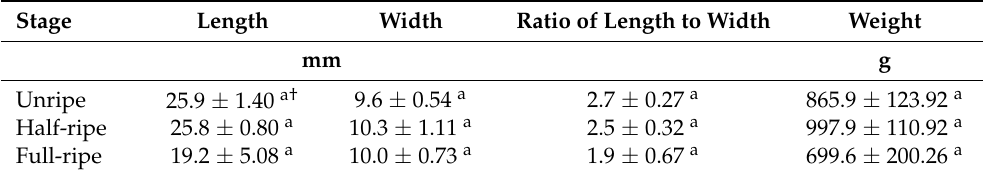
Table 1. Fruit length (mm), width (mm), the ratio of the length to the width, and weight (g FW)